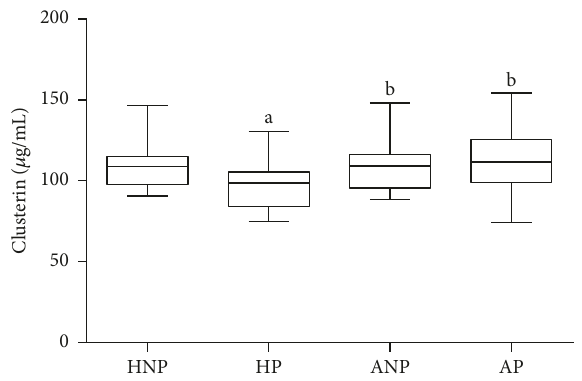
Figure 3: Circulating clusterin levels in healthy nonpregnant and pregnant and in asthmatic nonpregnant and pregnant subjects (data are expressed as median [interquartile range]). HNP: healthy non- pregnant; HP: healthy pregnant; ANP: asthmatic nonpregnant; AP: asthmatic pregnant. a 𝑝 < 0.05 versus HNP; b 𝑝 < 0.05 versus HP.